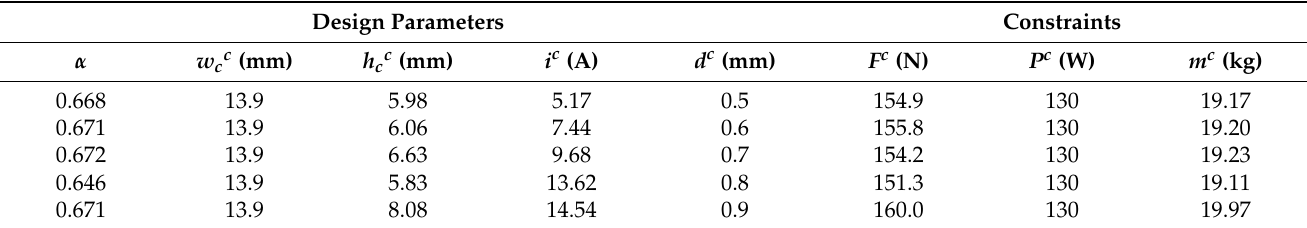
Table 5. Results of optimization with respect to the various coil